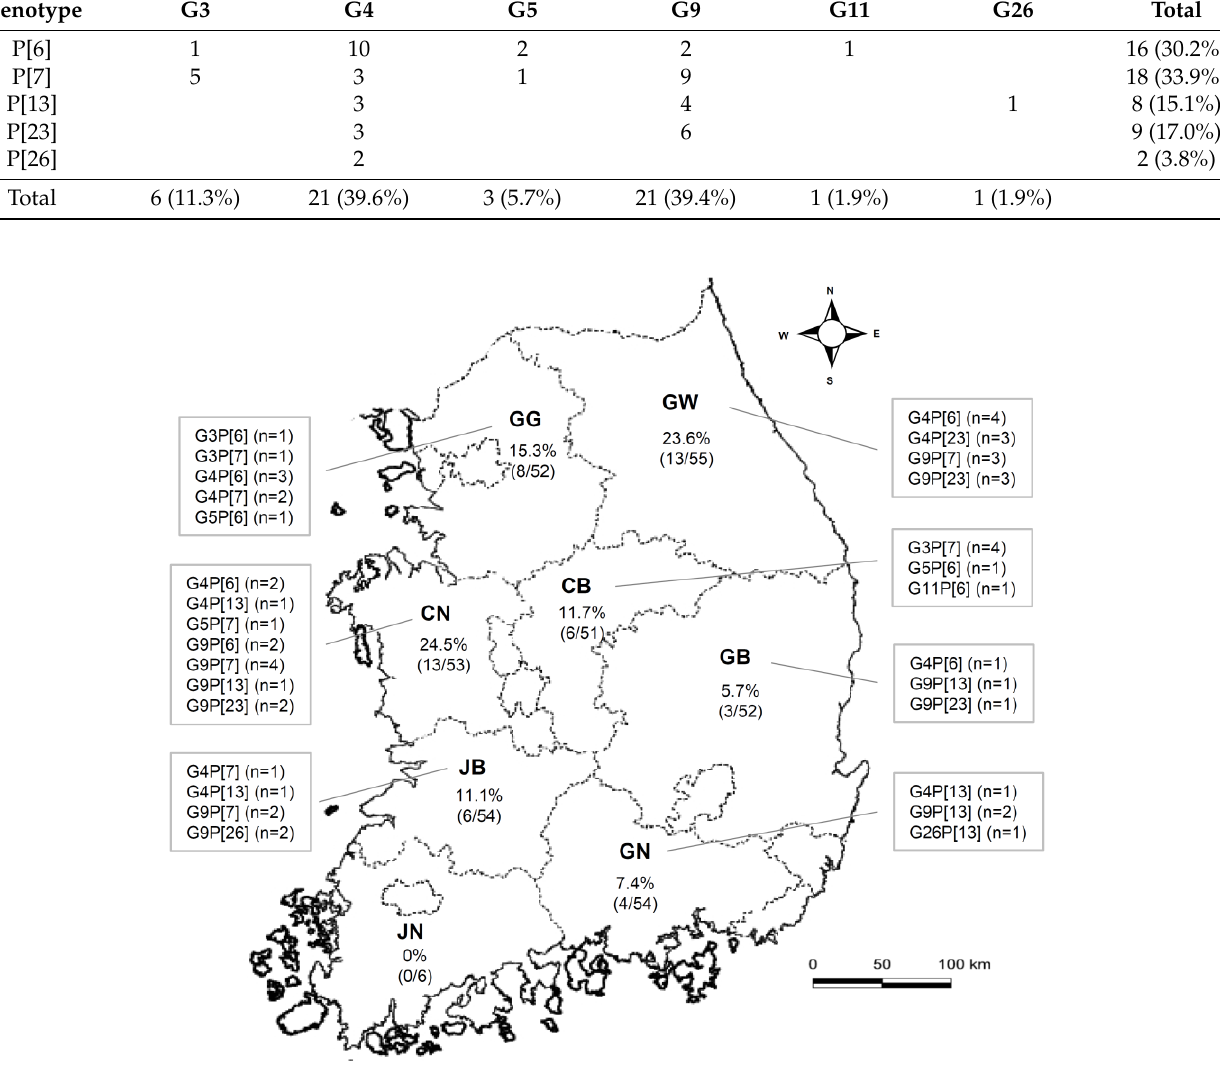
Figure 1. Regional prevalence of 53 PoRVA strains detected in Korean pigs between 2014 and 2018.